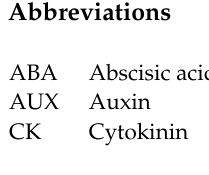
lines showing absence of expression of the indicated DNA methylation and demethylation-related genes in roots (A), shoots (B), floral tissues and organ (C), and various stages of embryogenesis (D). Scale bar = 5 mm, Supplementary Figure S2: Heatmap representation of gene expression levels of DNA methylation and demethylation-related genes across different tissues and organs, Supplementary Figure S3: RT-qPCR quantification of selected DNA methylation-related genes in 2-week-old wild-type Col-0 plants. A: Expression levels of VIM2 , CMT3 , and DRM3 in the roots of 2-week-old wild-type Col-0 plants. B. Expression levels of VIM2 , CMT3 , and DRM2 in the shoots of 2-week-old wild-type Col-0 plants. Relative fold change values were calculated from three biological samples and represent expression levels of CMT3 , DRM2 , or DRM3 relative to VIM2 , which were set to 1. Actin8 and PP2AA3 were used as internal control to normalize gene expression values. Average CT (cycle threshold) values of Actin8 and PP2AA3 were used to calculated ∆∆ CT values and gene expression levels. Asterisks indicate statistically significant differences from the expression values of VIM2 at p < 0.05 according to t -test, Supplementary Figure S4: GUS staining assays of transgenic reporter lines showing no changes in expression of the indicated DNA methylation-related genes in roots (A), or shoots (B) following treatment with (from left to right) auxin (AUX), cytokinin (CK), gibberellic acid (GA), ethylene (ET), abscisic acid (ABA), or salicylic acid (SA). Scale bar = 5 mm, Supplementary Figure S5: RT-qPCR quantification of selected DNA methylation-related genes in two-week-old wild-type Col-0 plants in response to the indicated phytohormone treatments. A: Expression levels of VIM1 in the root tissues of two-week-old wild-type Col-0 plants after ABA application. B: Expression levels of CMT3 in the root tissues of two-week-old wild-type Col-0 plants after AUX application. C: Expression levels of DRM2 in shoots of two-week-old wild-type Col-0 plants after GA application. Relative fold change values were calculated from three biological samples and represent expression in roots or shoots of hormone-treated plants relative to the corresponding tissues of mock-treated plants. Actin8 and PP2AA3 were used as internal control to normalize gene expression values. The average CT (cycle threshold) values of Actin8 and PP2AA3 were used to calculated ∆∆ CT values and gene expression levels. Asterisks indicate statistically significant differences between hormone-treated and mock-treated plants at p < 0.05 according to t -test, Supplementary Table